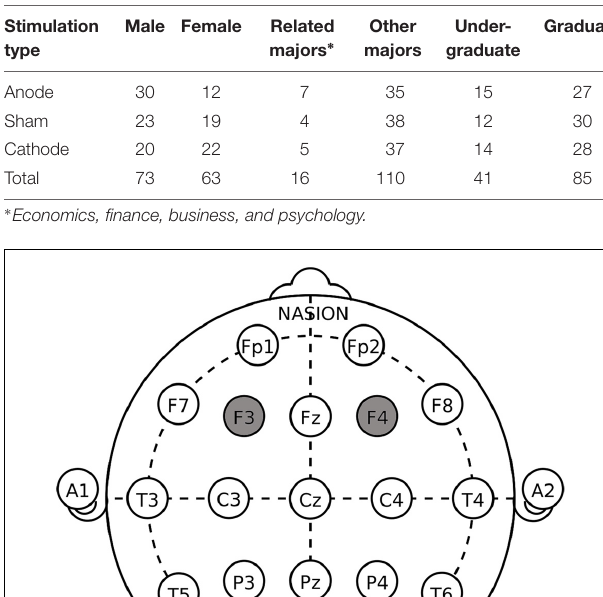
TABLE 1 | Number of subjects.